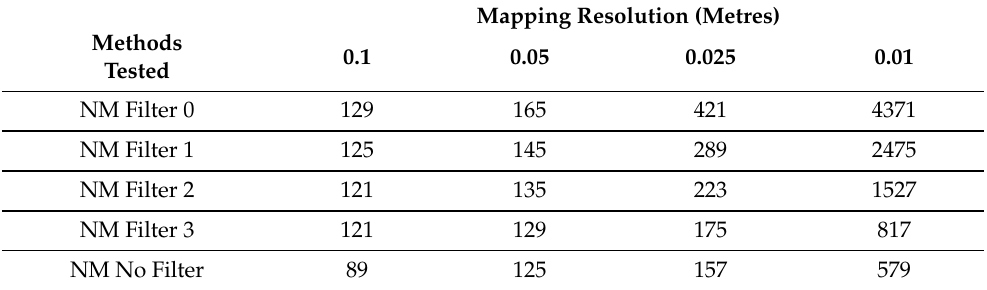
Table 3. NanoMap GPU memory consumption (MiB).